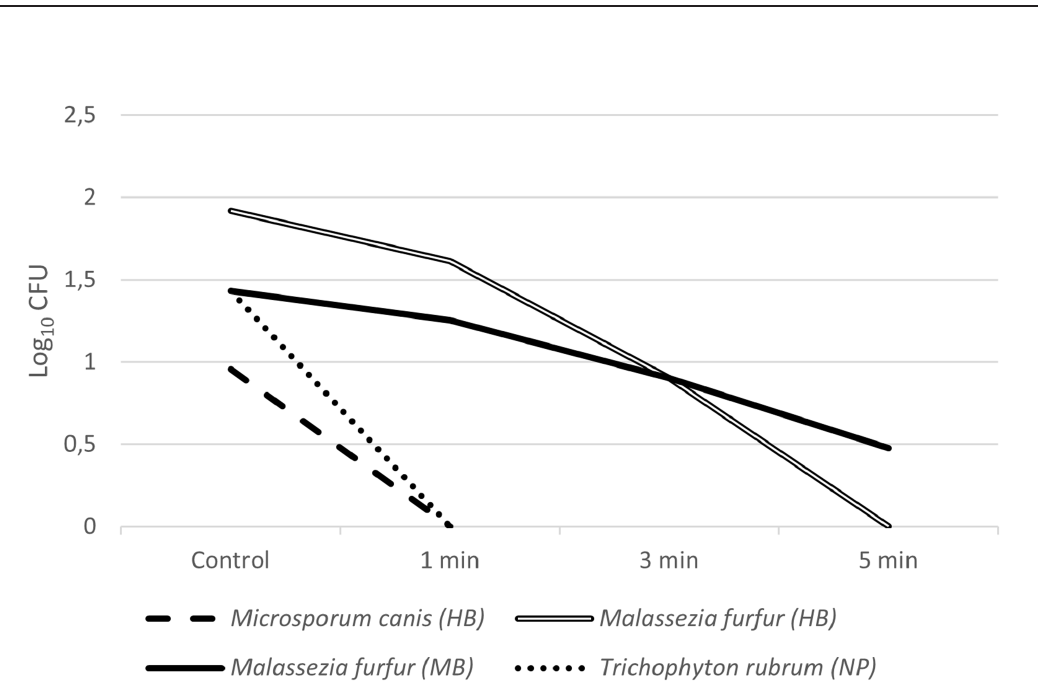
Figure 3. Average CFU count (Log CFU) of the microorganisms tested ( Mi. Canis , Ma. furfur , and 10 T. rubrum ) after exposure to UV-C light according to the tested times (control, 1 min, 3 min, and 5 min). HB: hairbrush, MB: makeup brush, NP: nail